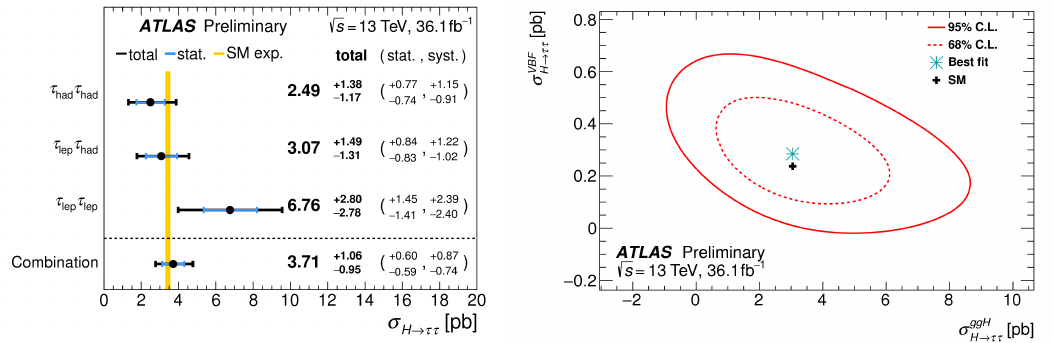
Figure 2: (a) Measured values for σ from individual channels. Also shown is H → ττ the result from the combined fit. The theory uncertainty in the predicted signal cross section is shown by the yellow band. (b) Likelihood contours for the combination of all channels in the depicted plane. [ 7